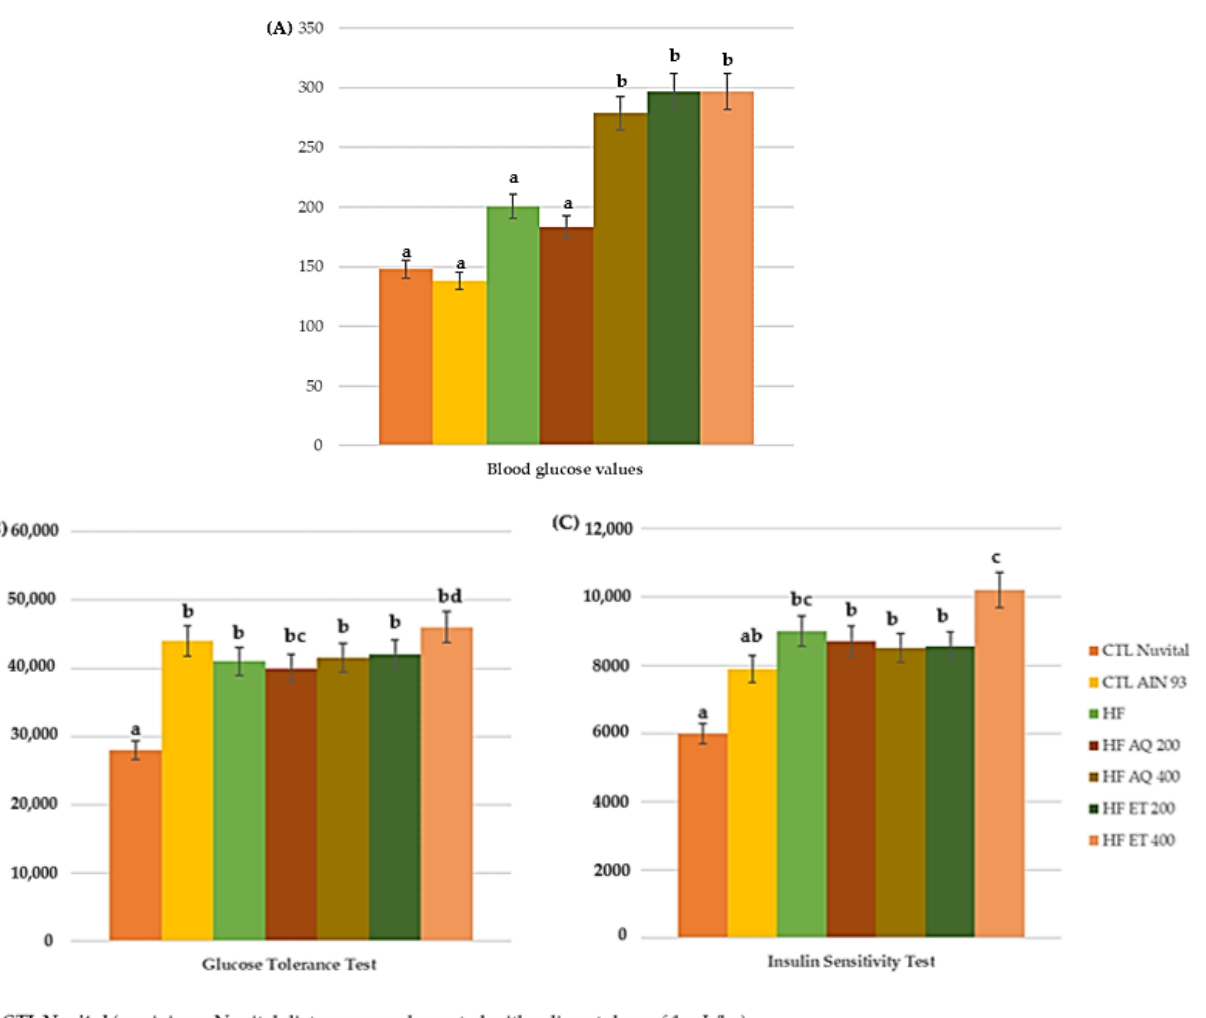
Figure 6. Blood glucose values (mg/dL) ( A ), and the area under the curve of the insulin sensitivity test (%) ( B ) and the oral glucose tolerance test (%) ( C ) of animals fed a balanced or high-fat diet and supplemented with saline, aqueous extract or ethanol extract of G. gardneriana leaves per day for 8 consecutive weeks. Values expressed as mean ± standard deviation. Different letters indicate a significant difference between groups and groups with the same letter are not significantly different. p < 0.05; n = 6 – 11; ANOVA followed by Tukey post-test.